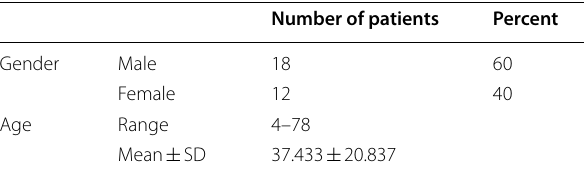
Table 1 Distribution of the studied cases according to demographic data ( n 30) = Number of patients